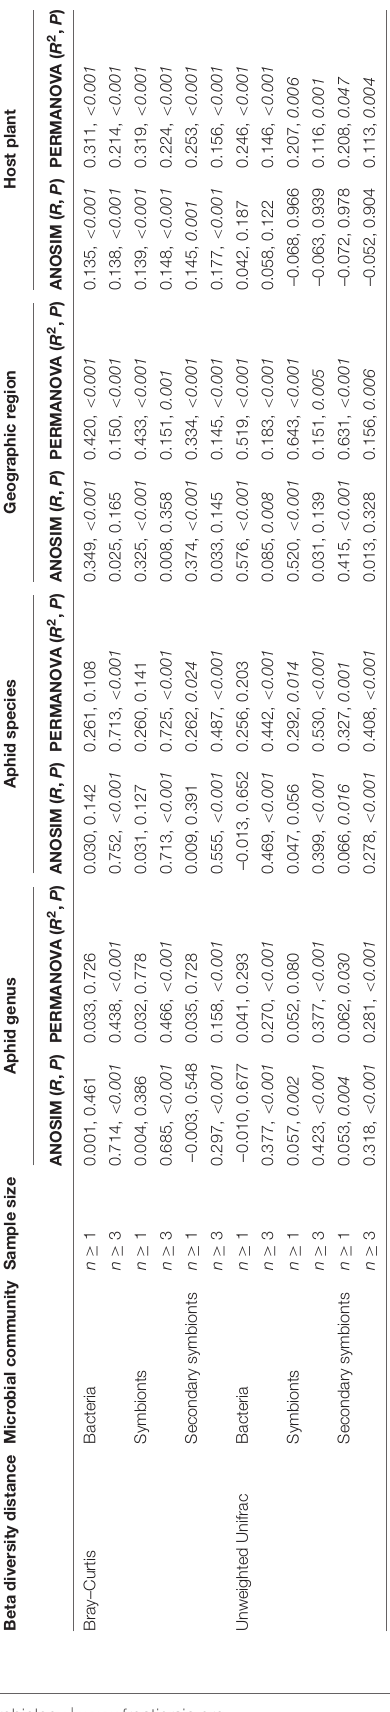
TABLE 3 | Correlations between microbial beta diversity and aphid phylogeny estimated by the Mantel test. Microbial community